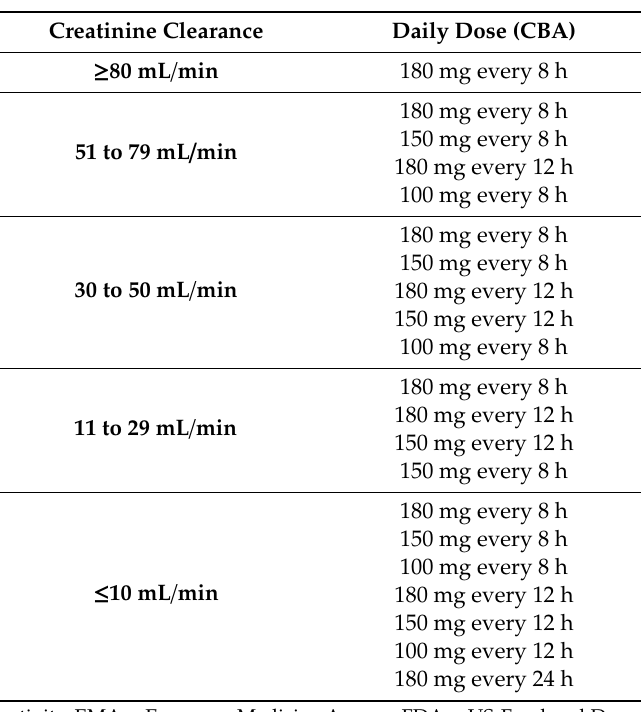
Table 3. Our study regimens for